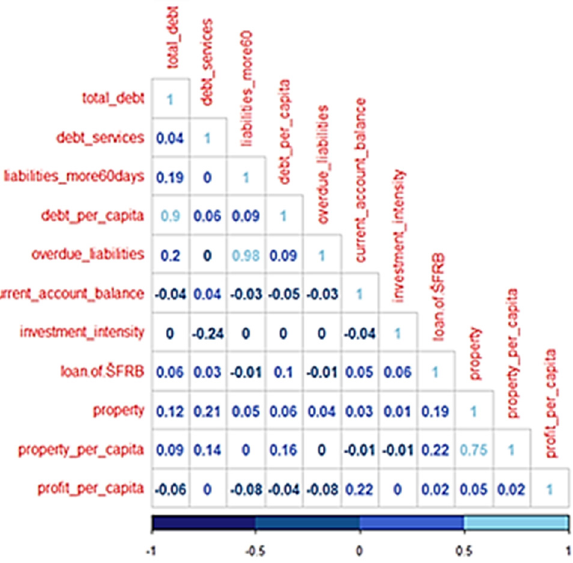
Figure 1. Testing the dependencies between variables using Pearson’s correlation coefficients. Source: own processing (R